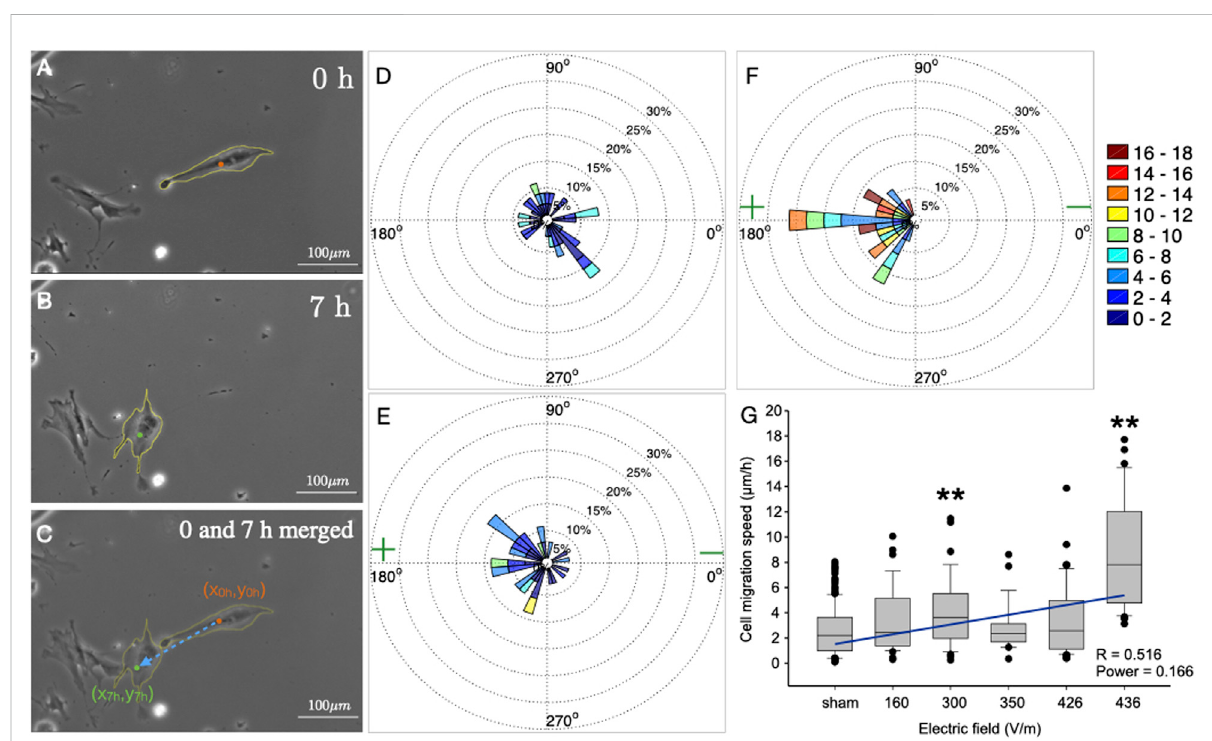
FIGURE 1 Single-cell analysis of migration of osteoblasts in a DC electric fi eld. (A – C) Photomicrographs of osteoblasts in stimulating chamber. Cell boundaries were manually outlined as depicted (yellow coastline). (A) Position of the cells before DC-stimulation. (B) Position of the same cells after 7 h DC-stimulation (436 V/m). (C) Overlay of (A,B) . The dashed blue arrow shows the displacement of the centroid of the same cell before (orange dot) and after (green dot) 7 h DC-stimulation. (D – F) Polar plots showing the velocity of cell migration in the cases of sham (D) , and DC stimulation of electric fi eld strength 160 V/m, (E) , and 436 V (F) . Each polar plot has been divided into 36 sectors, and data of cells migrating within each 10 ° sector are cumulated. The speed range is colour coded (in μ m/h) as shown in the colourbar. The relative sector lengths denote the percentage of cells migrating at a certain speed range. (G) Box and whisker plot of medians (horizontal lines) of cell migration speed vs. electric fi eld strength. Whiskers denote 25 – 75 percentiles of data distribution. Dots show data lying outside these percentiles. Numbers of cells for each experimentare:177,34,35,26,43,33forsham,and160,300,350,426and436 V/m,respectively.Bothat300 V/m,andatthemaximumstrengthof 436 V/m, the speed is signi fi cantly higher than under all other conditions (Asterisks denote p < 0.001; ANOVA on ranks, all-pairwise comparisons using Dunn ’ s